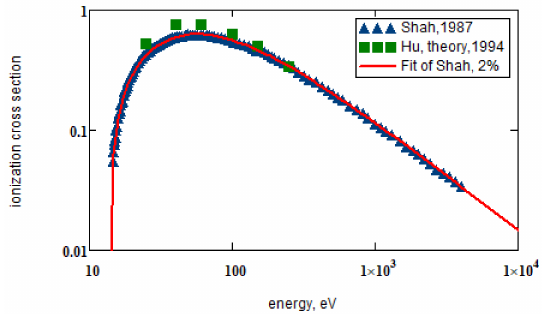
Figure 1. Electron impact ionization cross sections of hydrogen in Å 2